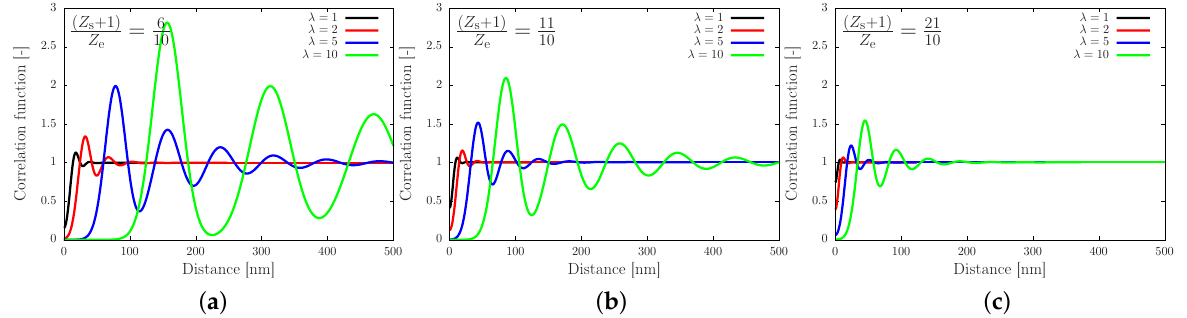
Figure 3. Correlation function against the distance from a sticker as given by Equation (4), for ( Z s + 1 ) / Z e equal to 6/10 ( a ), 11/10 ( b ) and 21/10 ( c ). The curves show an increasing amplitude and an increasing correlation length (distance of the first maximum) for a decreasing number of stickers. The amplitude and length scale are both enhanced by increasing the stretch ratio λ